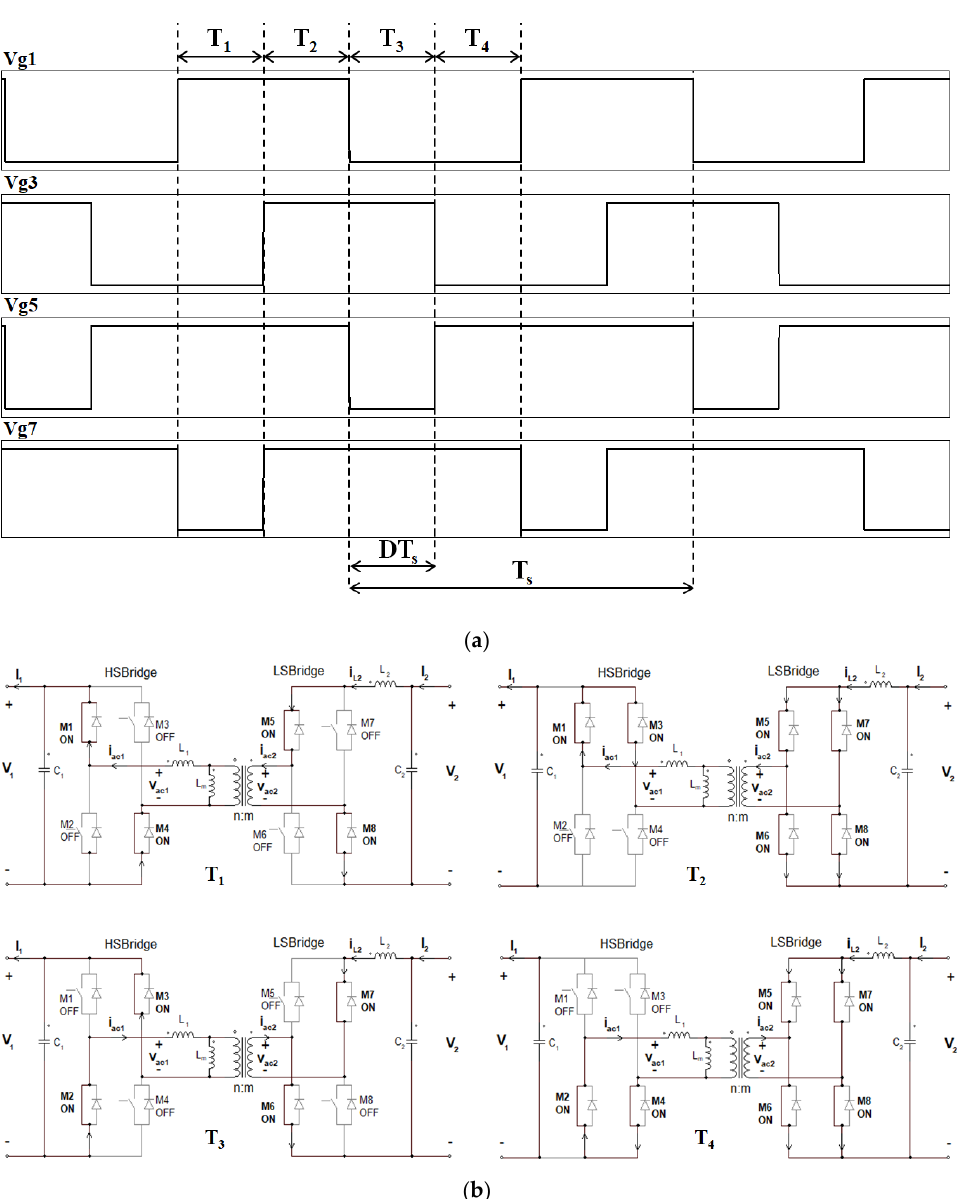
Figure 4. Phase Shift Modulation (PSM) case: ( a ) gate signals; ( b ) modes of operation.